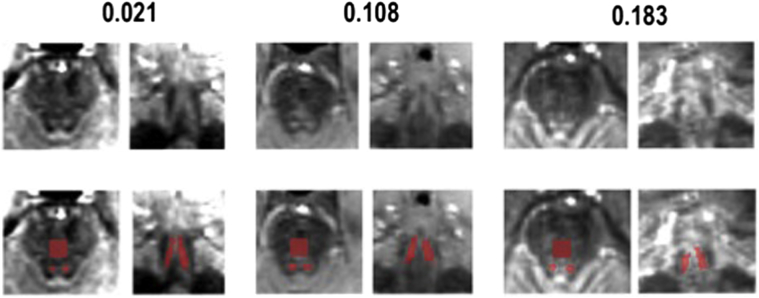
Cam-CAN MT-weighted images from three individual participants with LC and reference region (pons) segmentations (second row, red). The number above each image is the mean LC CR value for an individual participant, demonstrating that the LC can be visualized on individual scans as two areas of signal hyperintensity (first row) across the range of LC CR values, shown in axial (left) and coronal (right) views. In the second row, the large red square represents the reference region (pons). These images for each participant were visually assessed to ensure correct identification of the LC and to detect any significant movement artifacts. Abbreviations: CR, contrast ratio; LC, locus coeruleus; Cam-CAN, Cambridge Centre for Ageing and Neuroscience; MT, magnetization transfer. (For interpretation of the references to color in this figure legend, the reader is referred to the Web version of this article.)